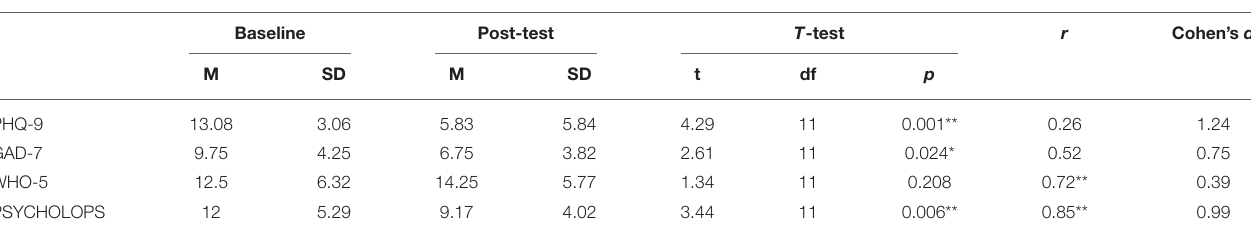
TABLE 3 | Baseline and post-test changes among completers.